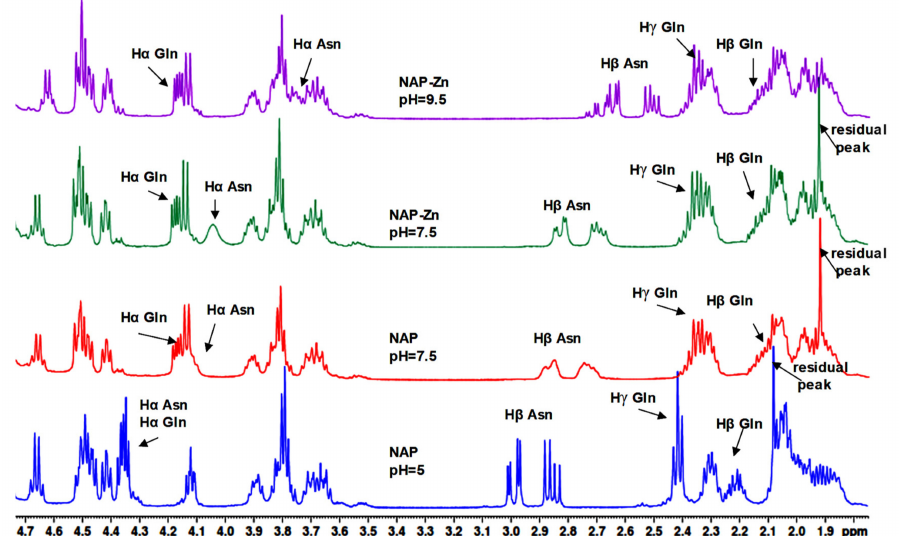
Figure 8. 1 H-NMR spectra of NAP peptide titrated with Zn 2+ ions at pH 7.5 and pH 9.5, at a 1:10 molar